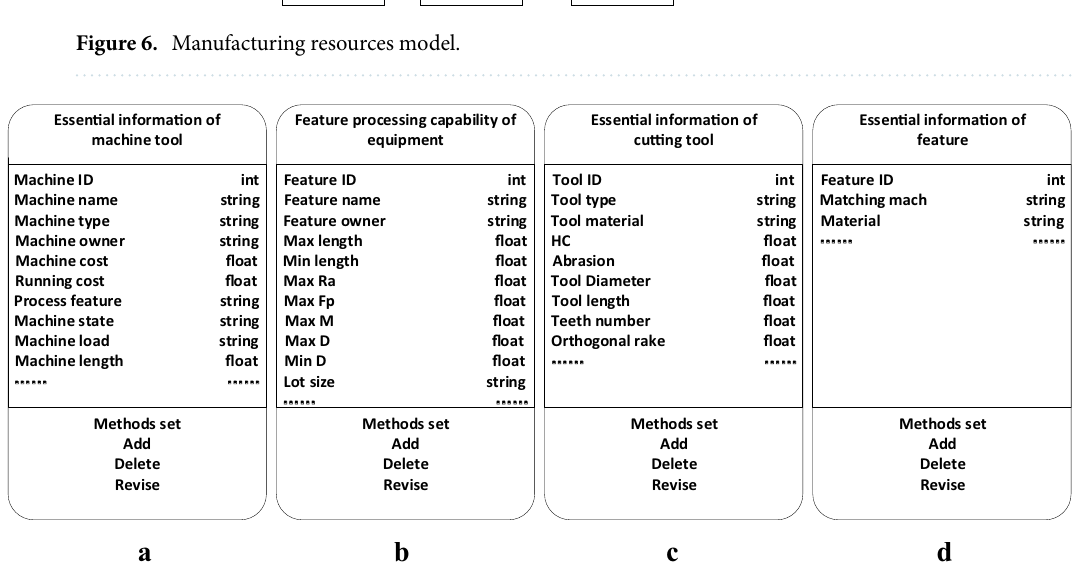
Figure 7. Object-oriented information model. ( a ) essential information of machine tool; ( b ) feature processing capability of the equipment; ( c ) essential information of cutting tool; and ( d ) essential information of the